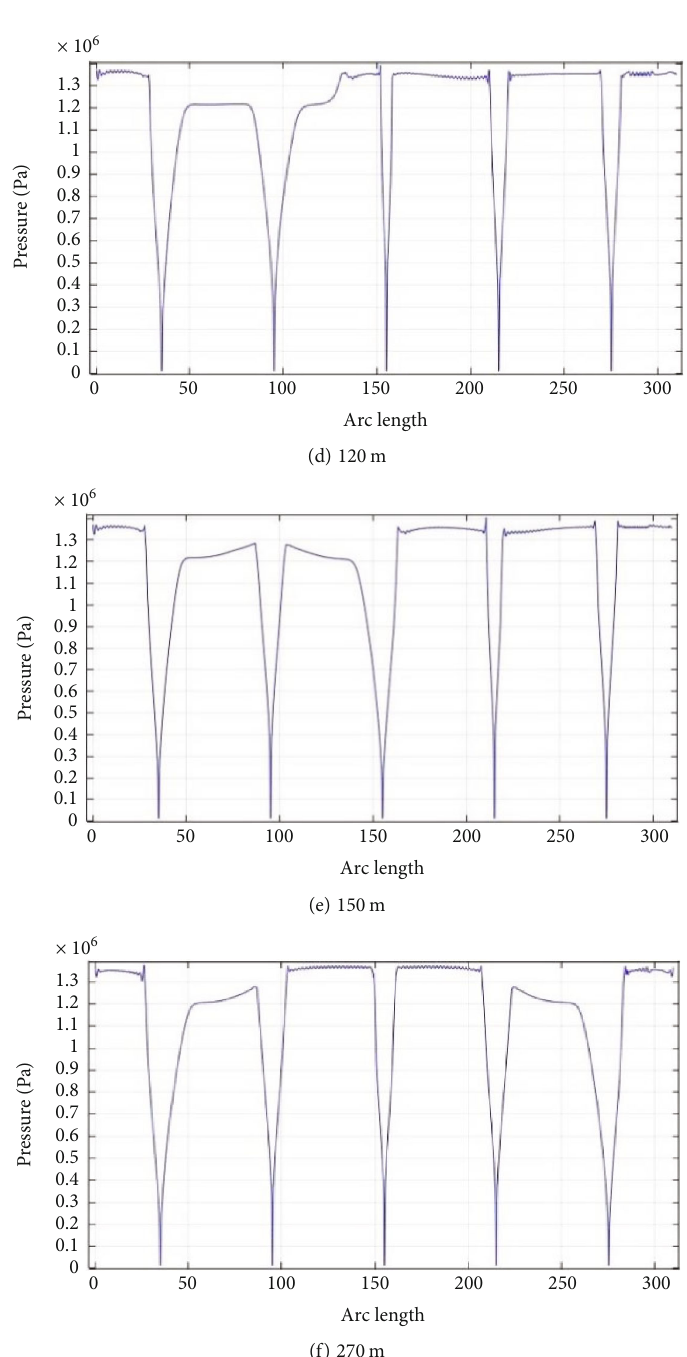
Figure 6: Curve of gas pressure distribution of gas drainage with pressure-relief